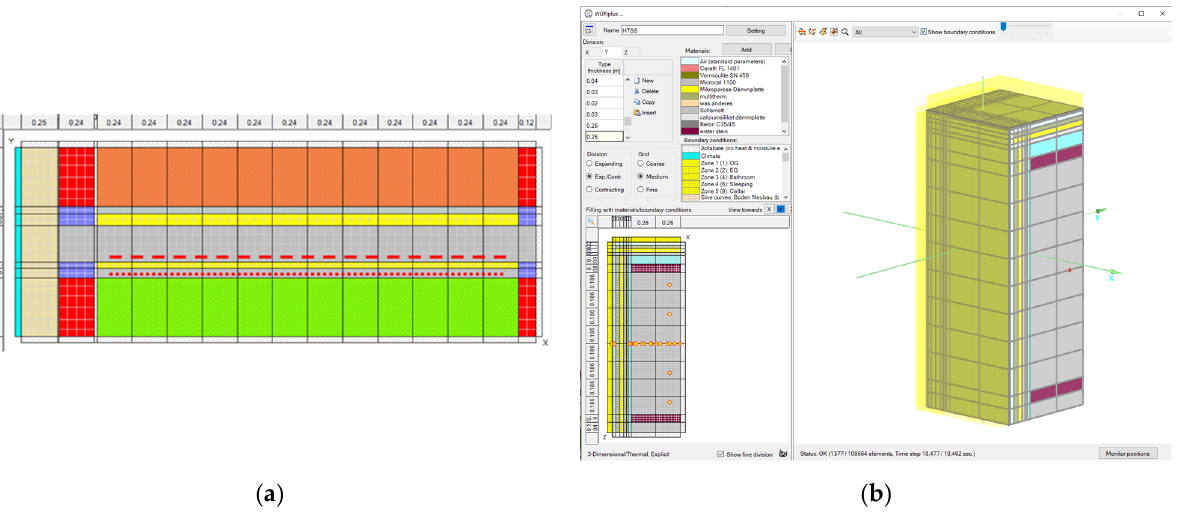
Figure 8. ( a ) Two-dimensional geometry representation of a thermally activated ceiling in the simulation software. The red dashed line indicates the position of the inner charging pipes and below the red dotted line indicates the pipes for the ceiling panel heating. ( b ) Three-dimensional geometry model of the high-temperature stone storage in the simulation software.